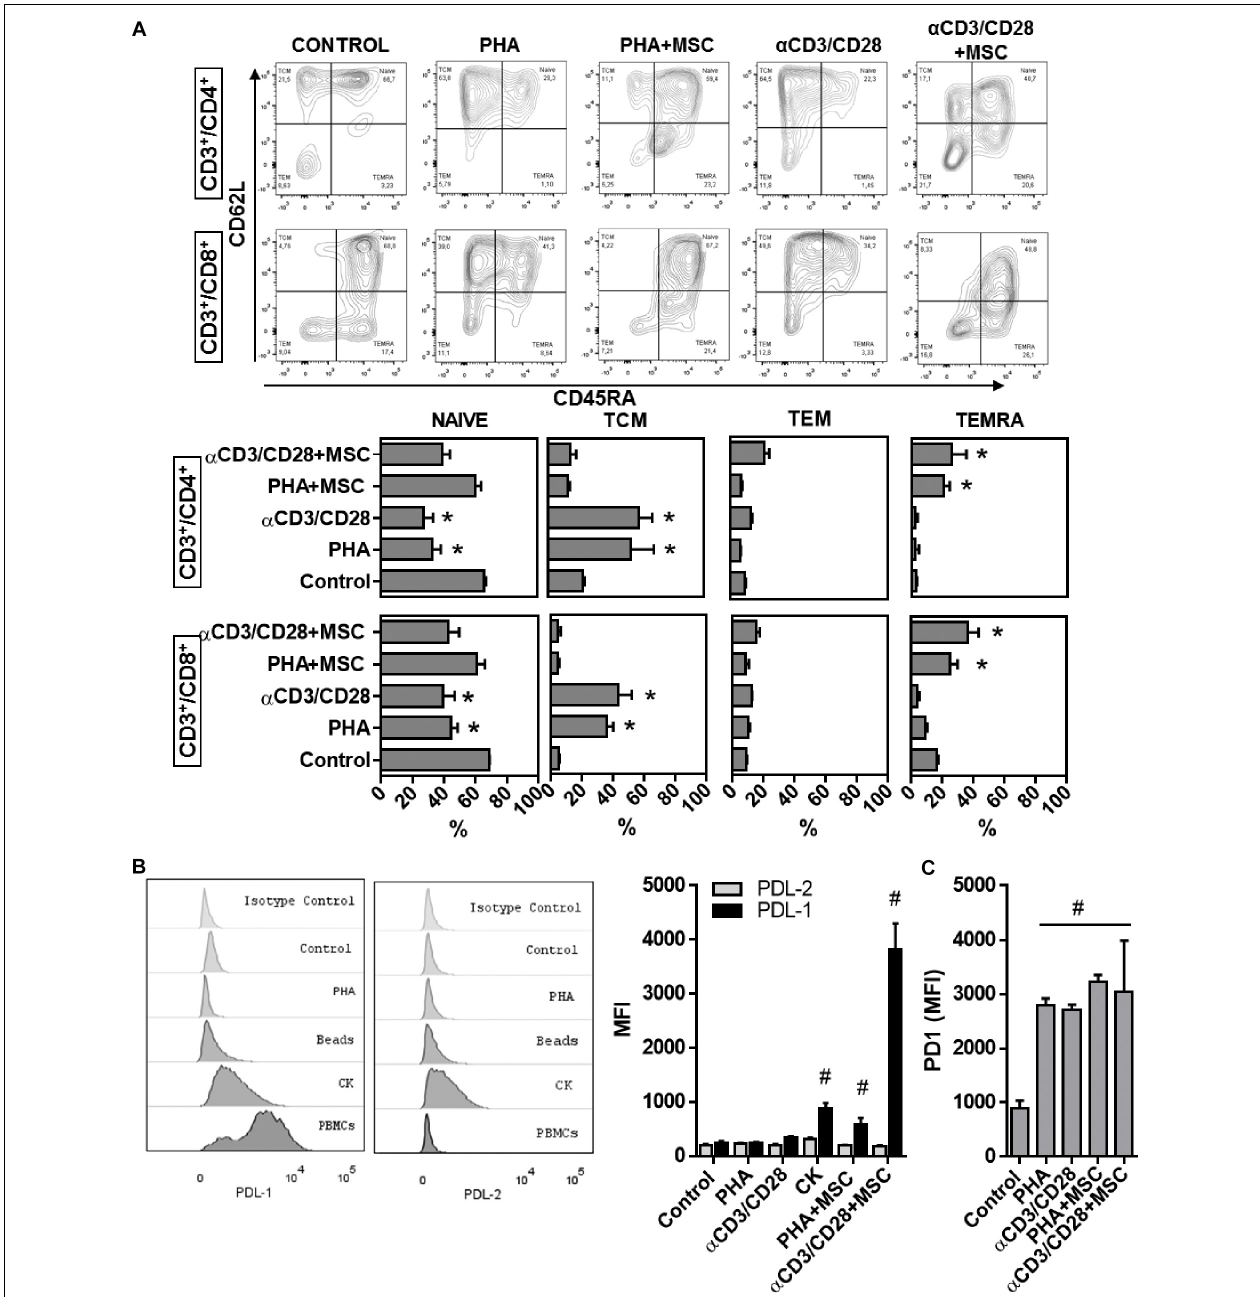
FIGURE 6 | Immune modulatory UC-MSC activate T cell regulatory pathways leading to reduction of activated T cells. (A) Flow cytometry analyses and percentages of naïve (NAÏVE, CD45RA + /CD62L + ), central memory (TCM, CD45RA - /CD62L + ), effector memory (TEM, CD45RA - /CD62L - ), and terminal effector (TEMRA, CD45RA+/CD62L - ) T lymphocyte subsets in CD3 + /CD4 + and CD3 + /CD8 + T cell populations in PBMNC or PBMNC/UC-MSC cocultures activated with PHA or α CD3/CD28 for 5 days (* vs. Control, p < 0.05, n = 3–5). (B) Expression of Programmed cell death protein ligand 1 (PD-L1) and 2 (PD-L2) in UC-MSC, assessed by flow cytometry following 5 days of treatment with PHA, α CD3/CD28, TNF α /IL1b (CK), PHA and α CD3/CD28-activated PBMNC/MSC (# vs. Control, p < 0.05, n = 6–8). (C) Programmed cell death protein 1 (PD-1) expression in CD3+ T cells 5 days stimulation with PHA, α CD3/CD28, TNF α /IL1b (CK), PHA and α CD3/CD28-activated PBMNC/MSC (# vs. Control, p < 0.05, n =